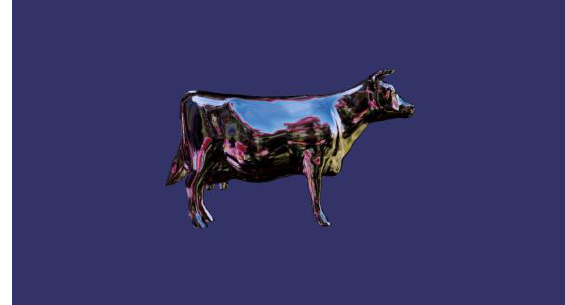
Figure 3. Test result